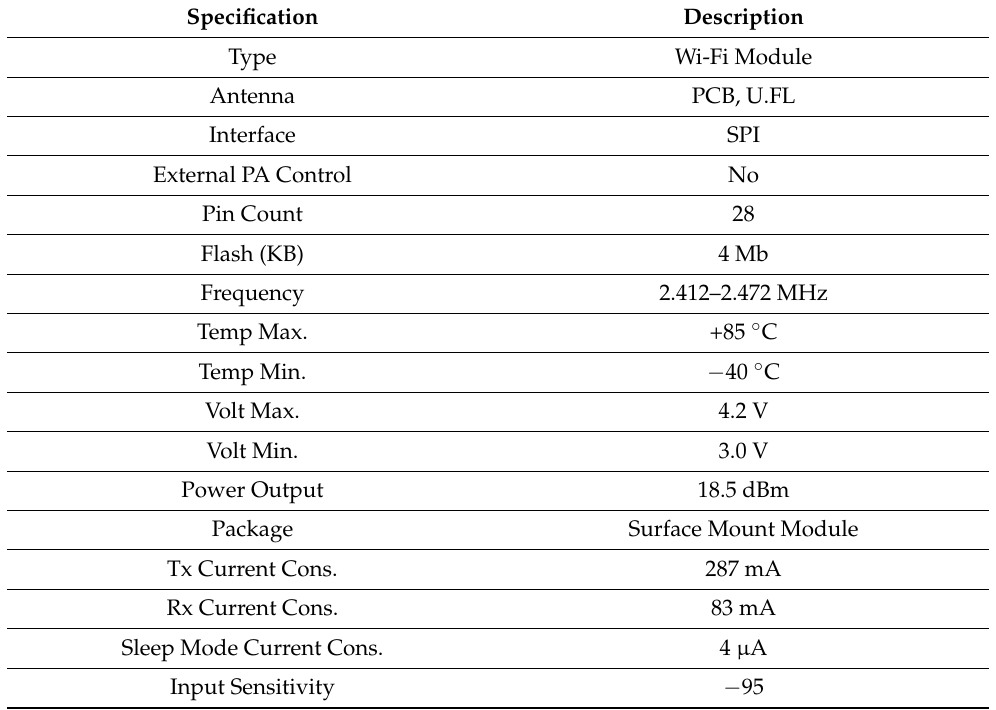
Figure 8. SHT click sensor module.